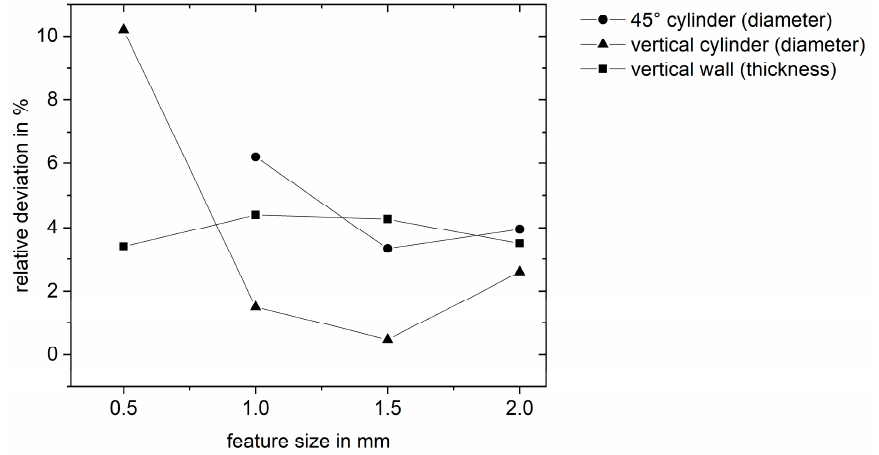
Figure 9. Relative deviation from the feature size of three different geometrical features (vertical wall, vertical cylinder, and 45° cylinder) analyzed from 3D scanning data points from the Cu-OFHC benchmark geometry.